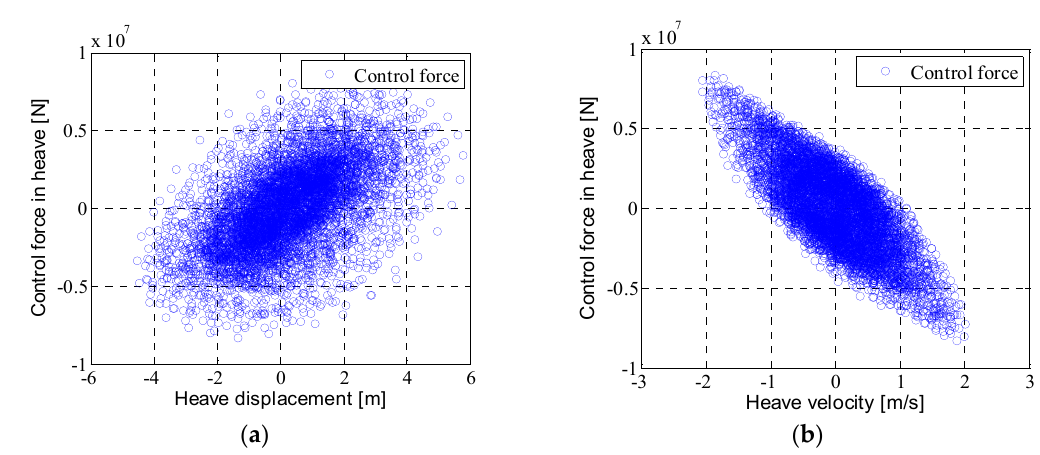
Figure 18. ( a ) The relation between the control force in the heave motion from the THPEH system and the heave displacement of the platform; ( b ) the relation between the control force in the heave motion from the THPEH system and the heave velocity of the platform.